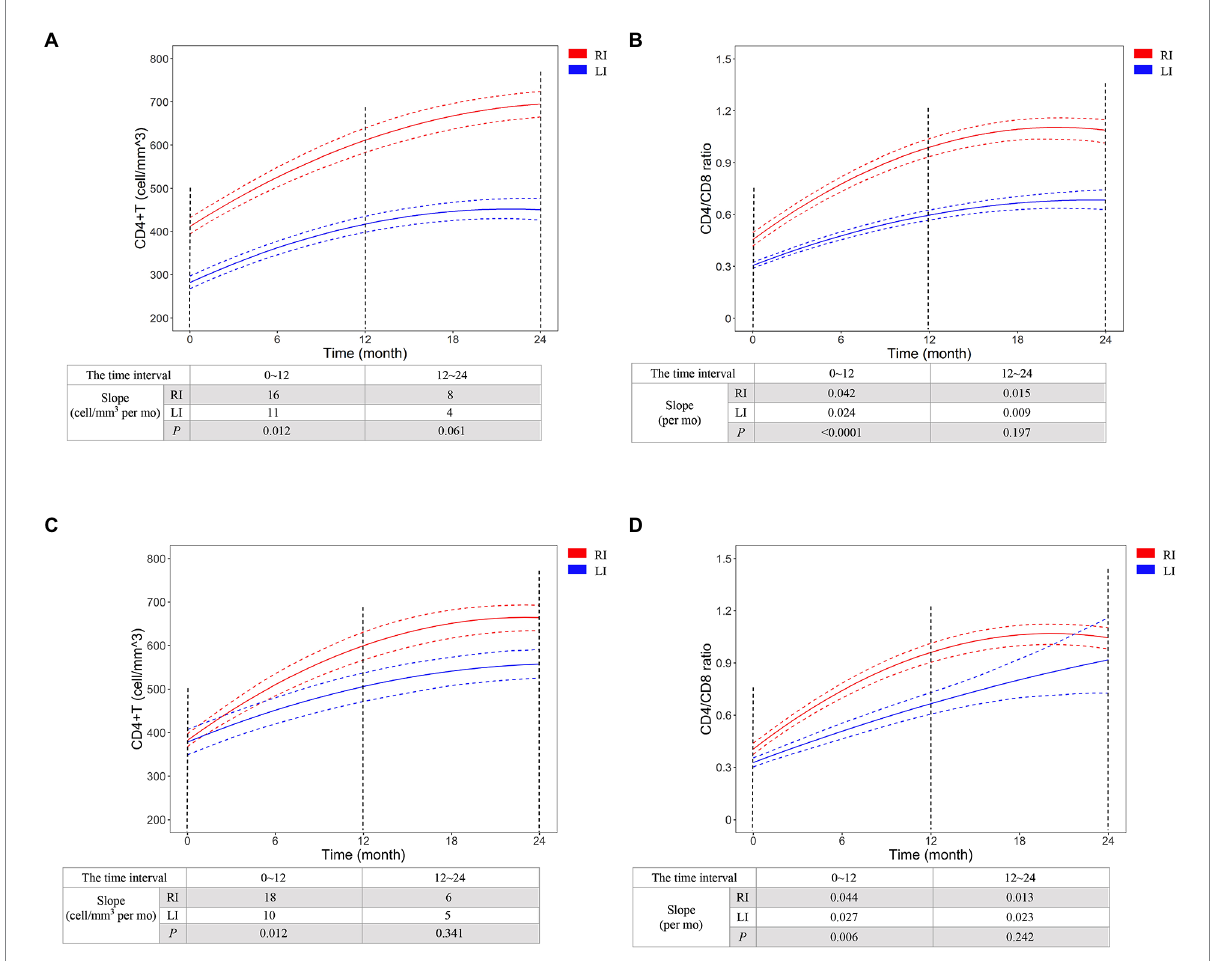
FIGURE 4 The recovery dynamics of CD4 + T-cell count (A,C) and CD4/CD8 ratio (B,D) after initiation of cART for HIV-1 recent and long-term infection patients. CD4 + T-cell count and CD4/CD8 ratio were detected in all 200 cART-treated patients (A,B) or the patients of 1:1 case–control analysis using propensity score matching method. The dynamics was predicted by Generalized Estimating Equations (GEE) and compared between HIV-1 recent and long-term infection patients. The red and blue dash lines represent 95% pointwise confidence bands. RI, recent infection; LI, long-term infection. RI, recent infection; LI, long-term